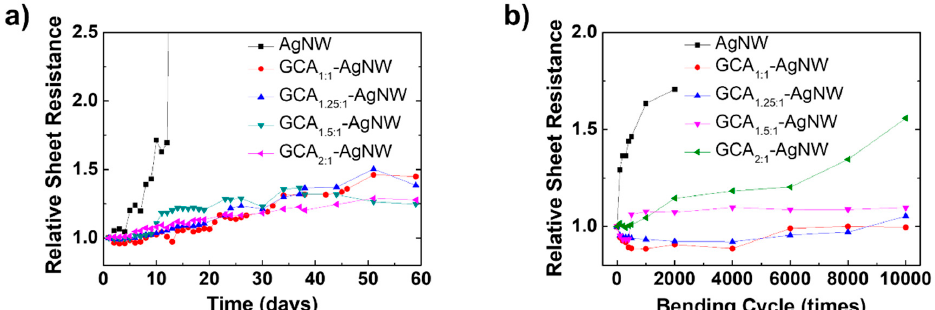
Figure 6. Mechanical characteristics of AgNWs and GCA–AgNW. ( a ) Sheet resistance stability test for